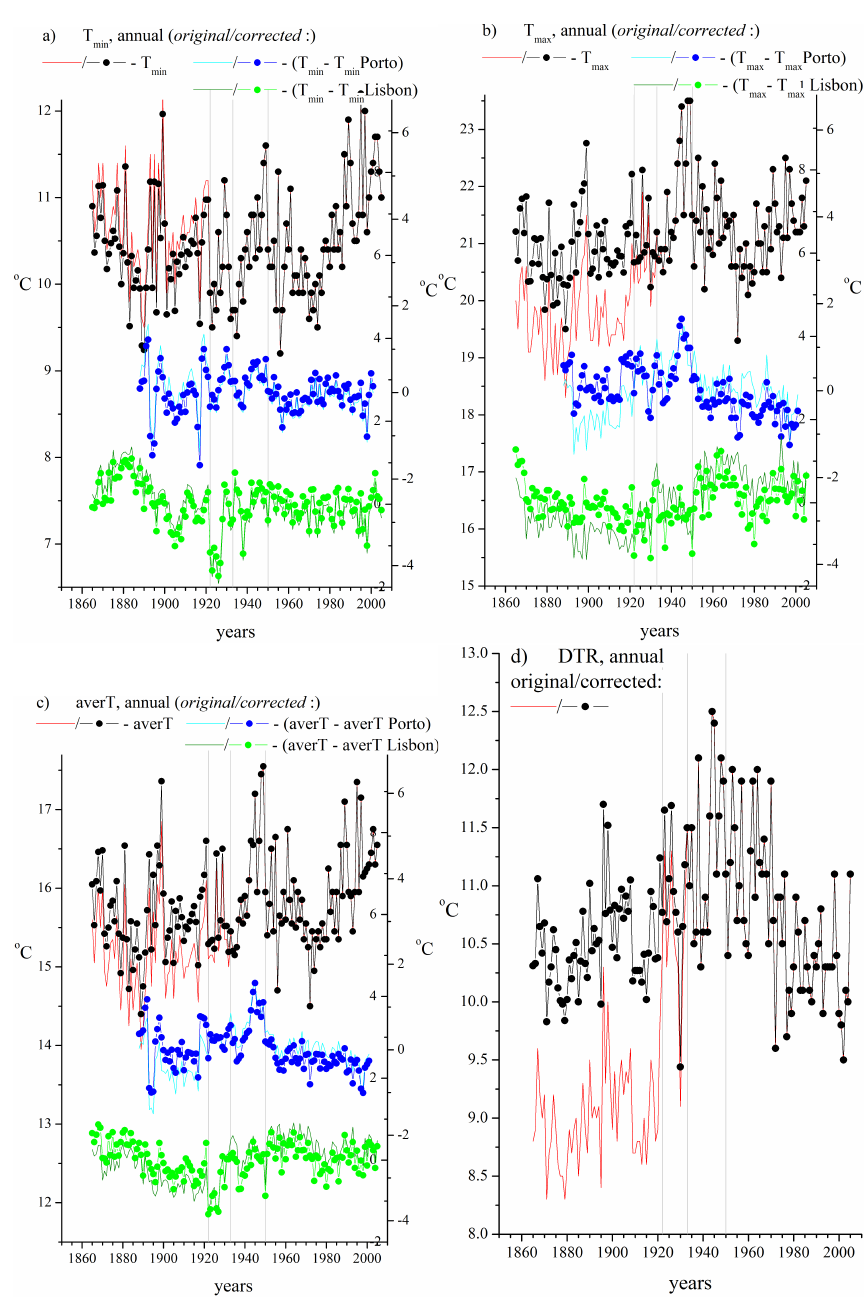
Figure 23. Coimbra: original and corrected annual series of T min (a) , T max (b) , T aver (c) and DTR (d) ; Coimbra temperature series (red and black) and di ff erences between Coimbra and Porto (cyan and blue) and Lisbon (dark green and green) temperature series. Grey vertical bands show dates of known instruments relocation (see Table